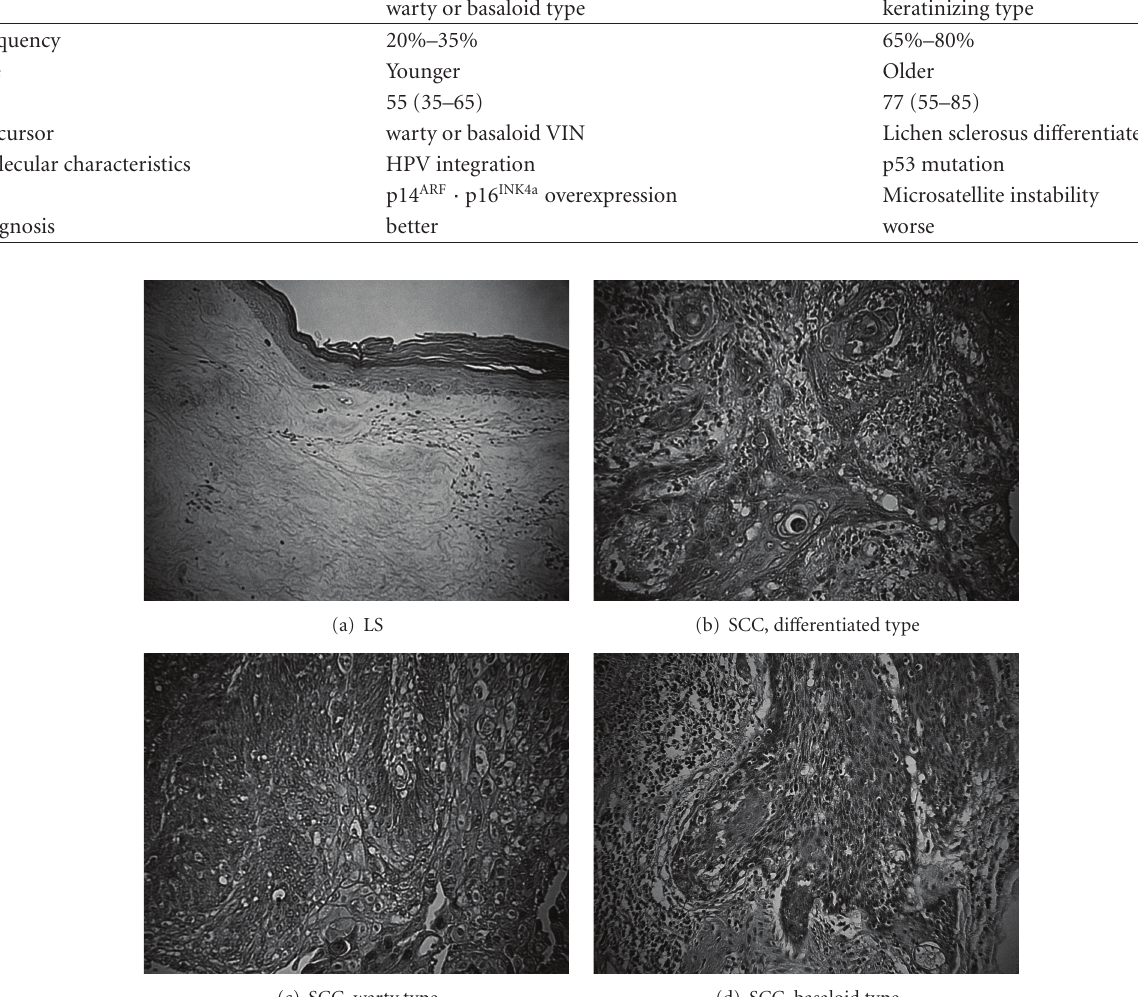
Table 1: Characteristics of two types of squamous cell carcinoma of the vulva. (Characteristics of the warty/basaloid type and the keratinizing type of SCC of the vulva are shown).